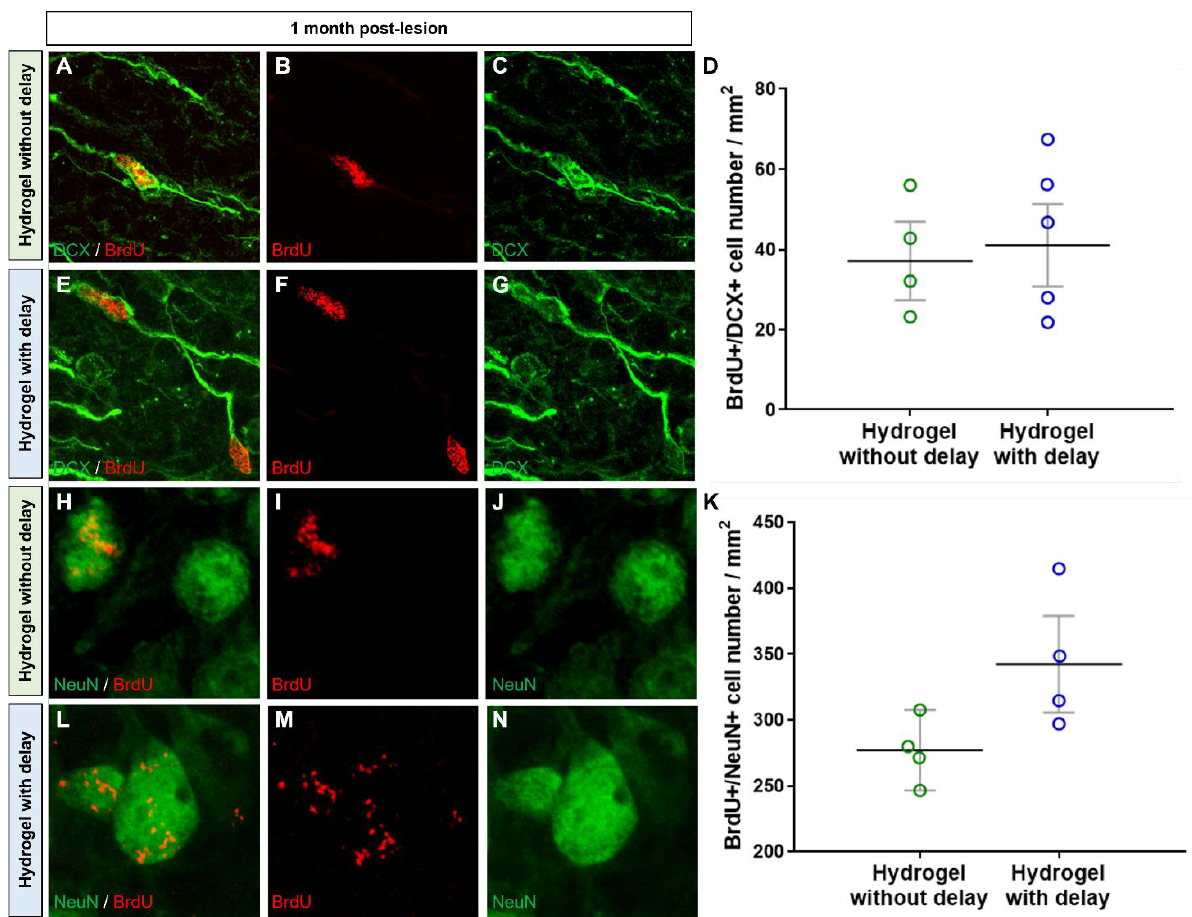
Figure 9. Newly generated neuroblasts and mature neurons into hydrogel. ( A – N ) Representative immunofluorescence images of newly generated BrdU+ cells (red) colocalized with DCX (green, ( A – G )) or with NeuN (green, ( H – N )) in hydrogel in no delay ( A – C , H – J ) or in delay ( E – G , L – N ) hydrogel implanted groups. ( D , K ) Quantitative analysis of the BrdU+/DCX+ neuroblasts ( D ) or BrdU+/NeuN+ neurons ( K ) within hydrogel delay (green) or no-delay (blue) groups. Mann–Whitney test.